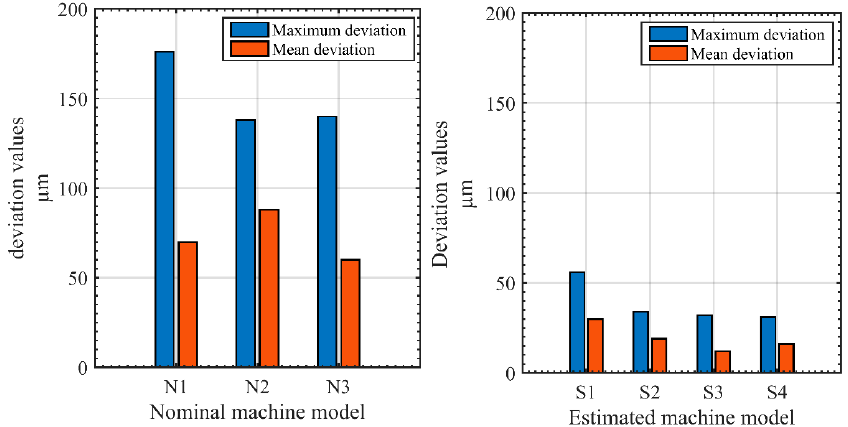
Figure 7. Deviation for nominal and estimated machine.